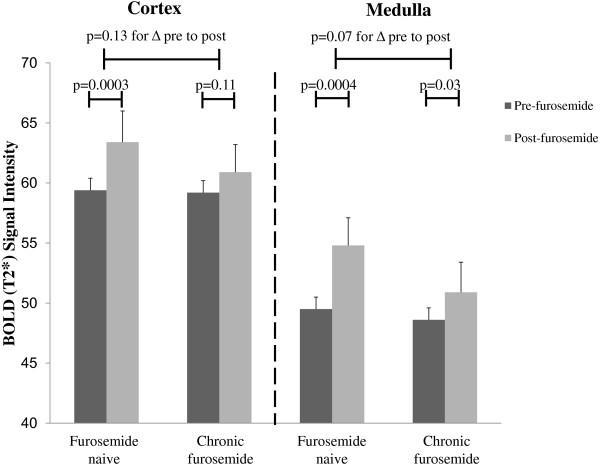
Bar graph displaying mean ± SE renal cortical and medullary BOLD signal intensities (T2*) prior to (light gray) and after (black) a 20 mg intravenous furosemide stimulus in furosemide naïve participants compared with participants chronically receiving furosemide.